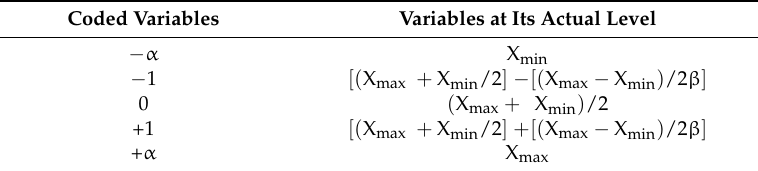
Table 2. The coded form and the actual level of the independent variables.